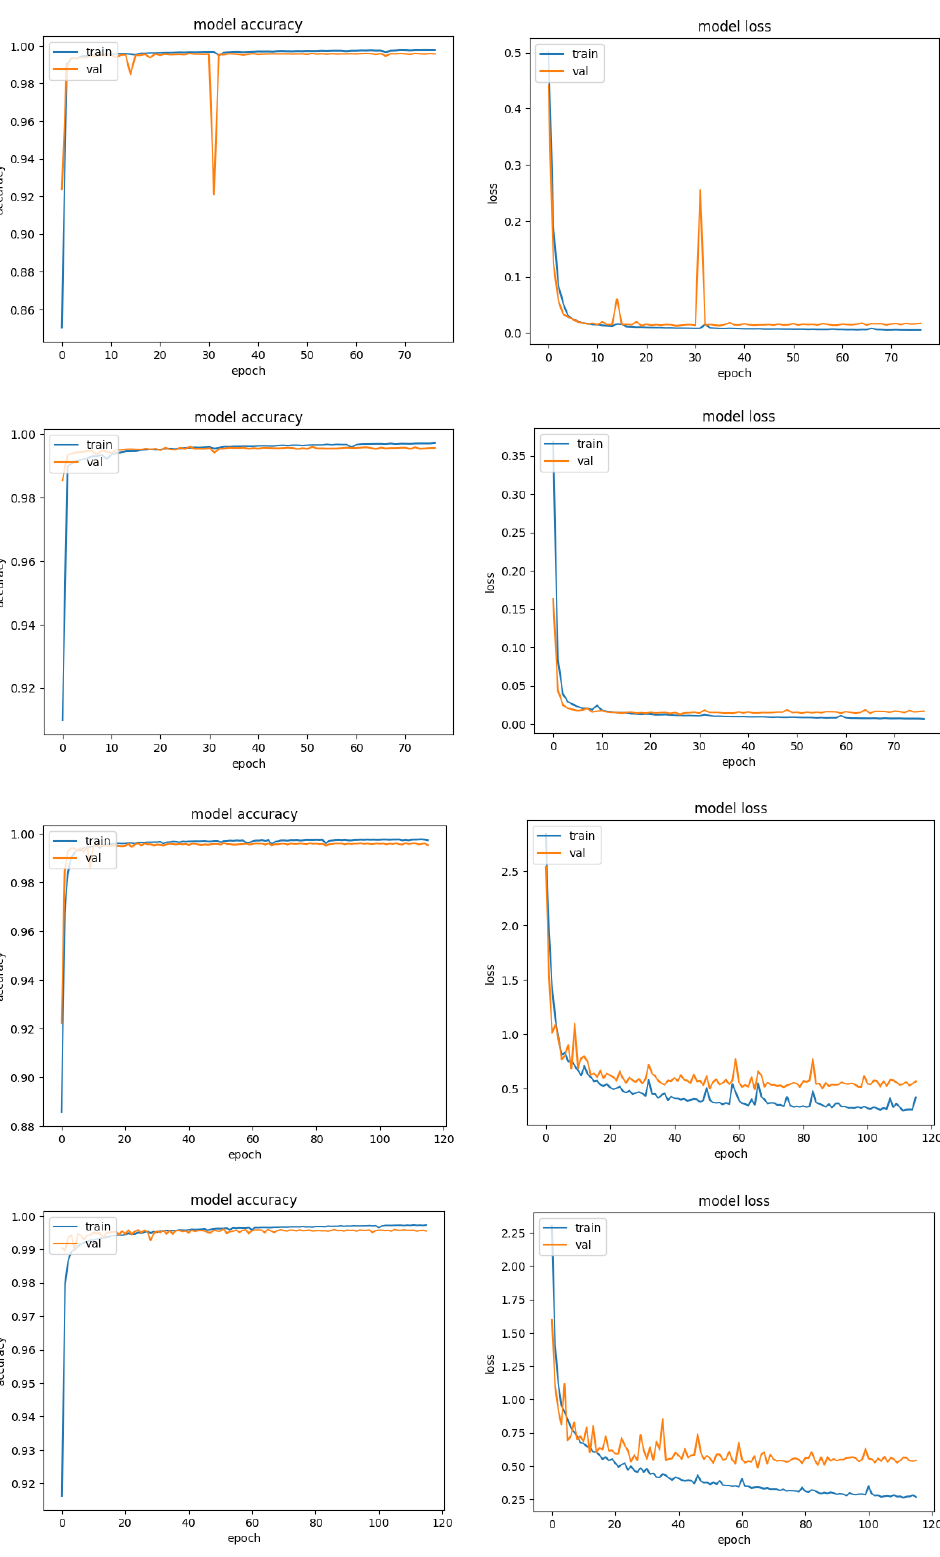
Figure 9. Accuracy and loss of the training and validation datasets per training epoch for SegNet. First Row: baseline, BCE loss, trained on no patch. Second Row: baseline, BCE loss, trained with patches. Third Row: baseline, Jaccard loss, trained on no patch. Fourth Row: baseline, Jaccard loss, trained with